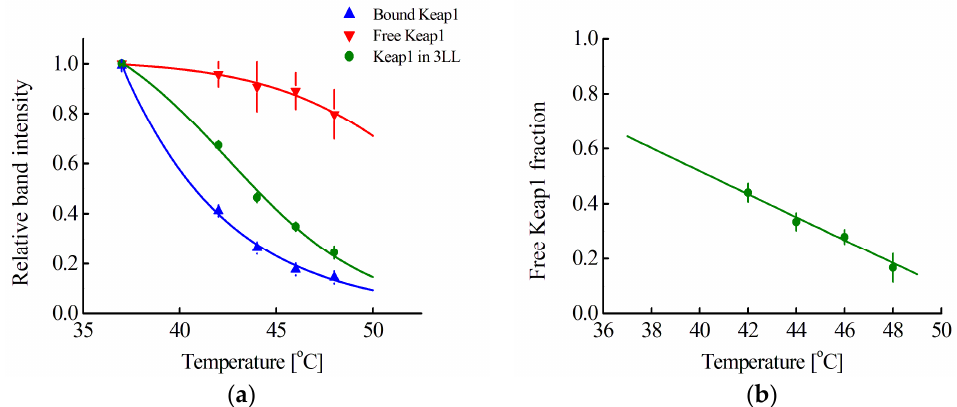
Figure 4. ( a ) Melting curves averaged over Hepa1, MEF, and RAW264.7 cell lines of bound Keap1 and Keap1 in 3LL cell lysate and reconstructed curve of free Keap1. The dependences are normalized to the band intensity at 37 °C ; ( b ) Dependence between free Keap1 fraction in 3LL cell lysate and temperature. The green line shows the linear extrapolation of experimental data to 37 °C . Standard errors (SE) are shown ( n = 4–12).